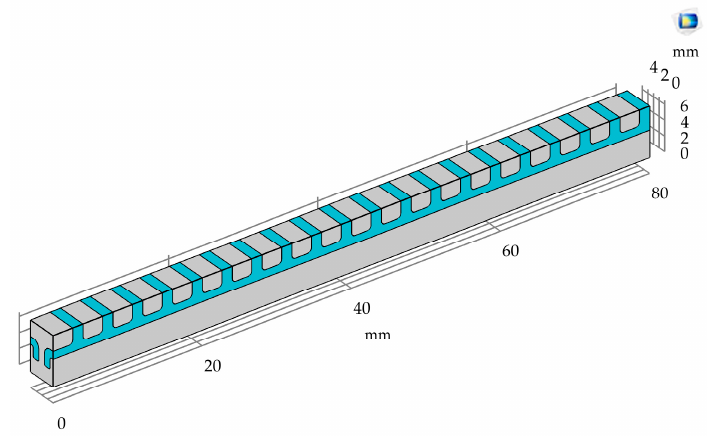
Figure 14. Flow regime as set-up in COMSOL Multiphysics.